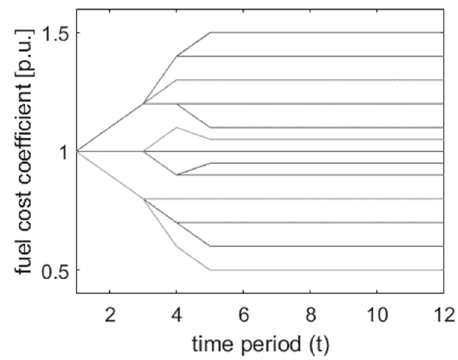
Figure 4. Fuel cost coefficient scenarios, FC t , i . Figure 4 . Fuel cost coefficient scenarios, , t i FC .